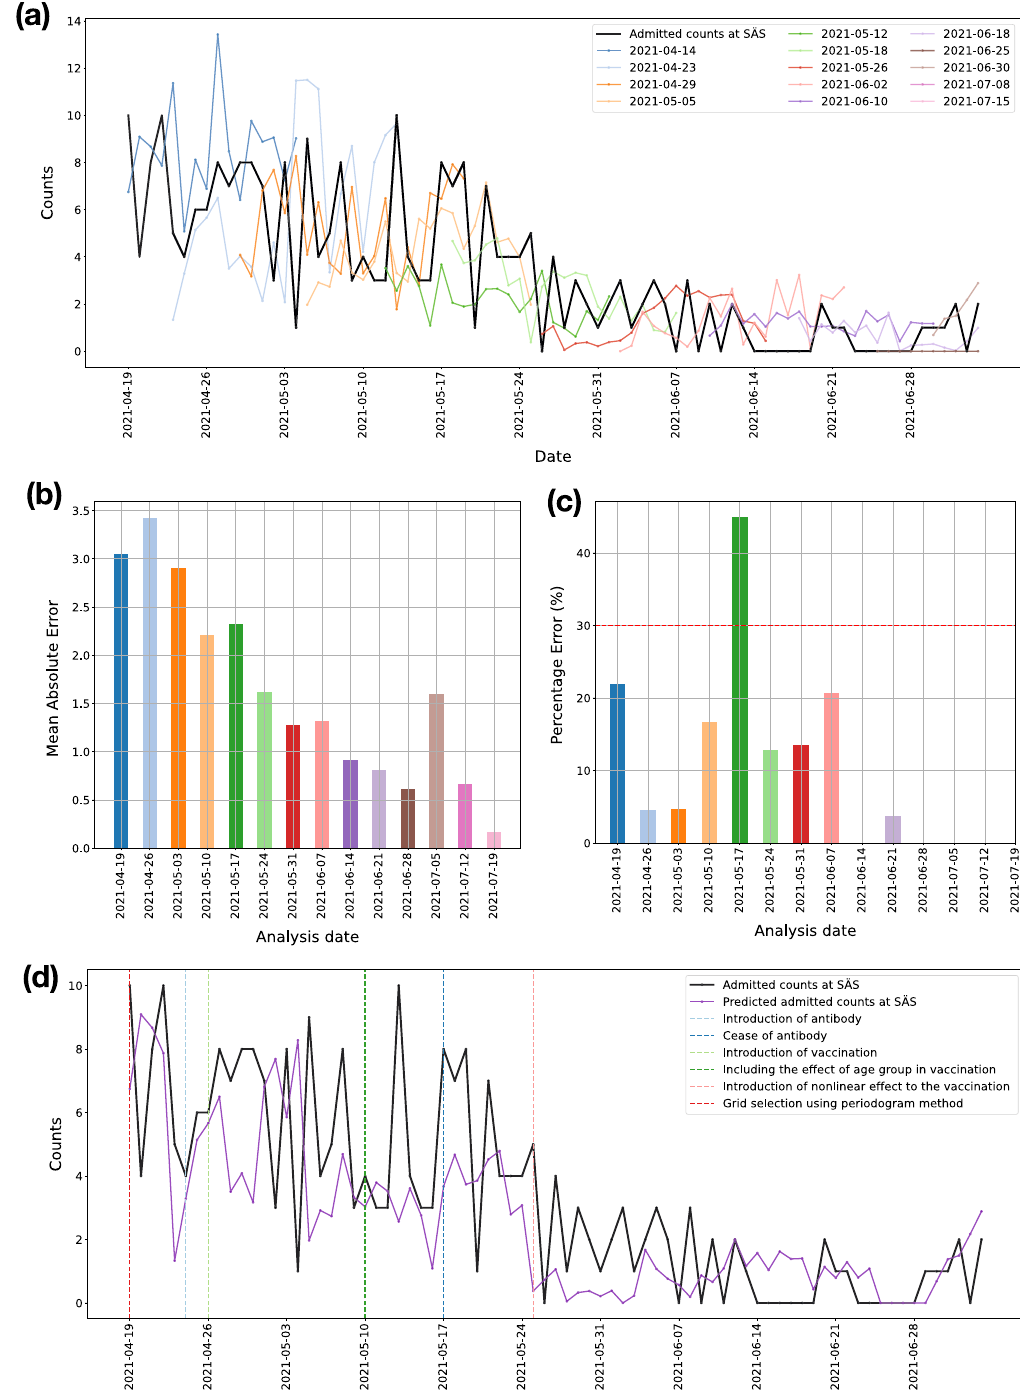
Figure 7. Prediction of the number of admitted COVID-19 patients at Södra Älvsborgs Hospital (SÄS). Forecast models were run regularly for 14 analysis dates (deliverable dates) starting from April 19, 2021 until July 19, 2021. ( a ) Forecasts from the 21-day forecast model at each analysis date. ( b ) Error in prediction in terms of the mean-absolute-error between true and predicted number of admitted patients, averaged across the duration of the forecast window. ( c ) Error in prediction in terms of the percentage error score per analysis date, averaged across the duration of the forecast window. Percentage errors are not shown for those analysis dates for which the total number of admitted patients were fewer than 15 patients. In 8 out of 9 analysis dates, for which the total number of admitted patients were more than 15 patients, the error is less than 30%. ( d ) Prediction of the number of admitted patients considering forecasts from latest models, built using the latest available data. The evolution of the forecast models is highlighted with markers indicating the major changes to the forecast